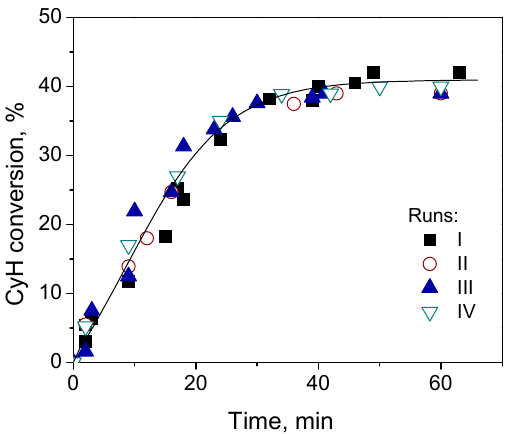
Figure 8. The plots of CyH conversion vs. time in CyH oxidation with H 2 O 2 over MIL-125-L in the presence of HClO 4 . Reaction conditions: CyH 0.1mmol, H 2 O 2 0.1 mmol, catalyst 0.01 mmol Ti, HClO 4 0.01 mmol (added in each run), CH 3 CN 1 mL, 50 ◦ C, 1 h.